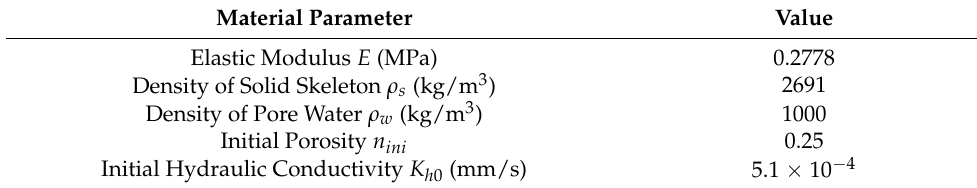
Table 1. Parameter values for the plastic settlement analyses.